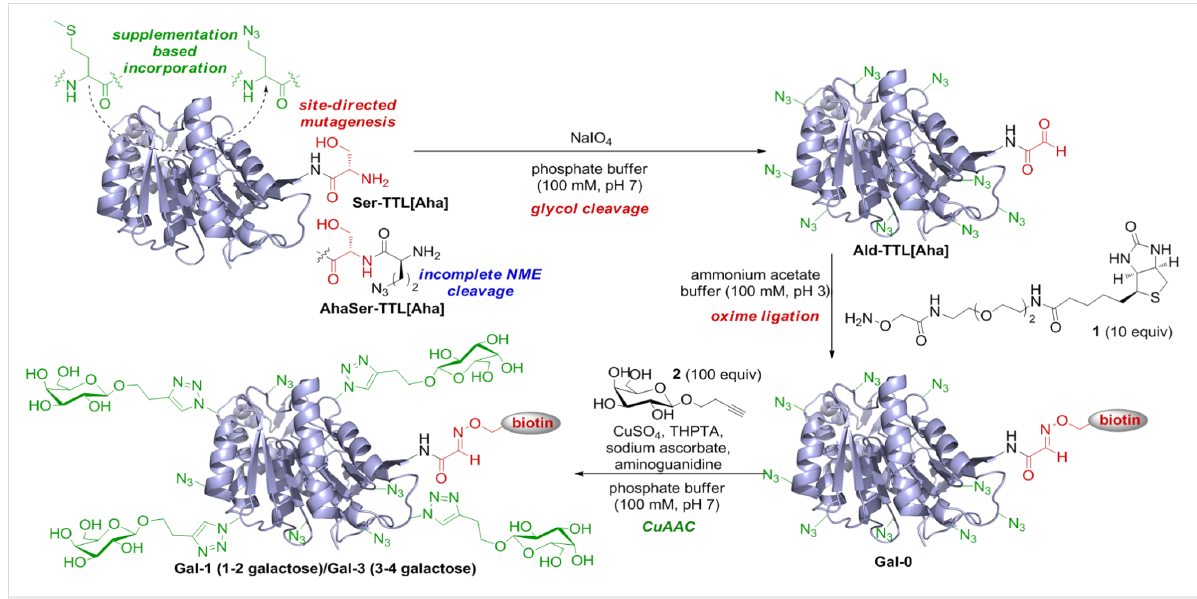
Scheme 1: Protein design and dual-functionalization of TTL: periodate cleavage, oxime ligation and